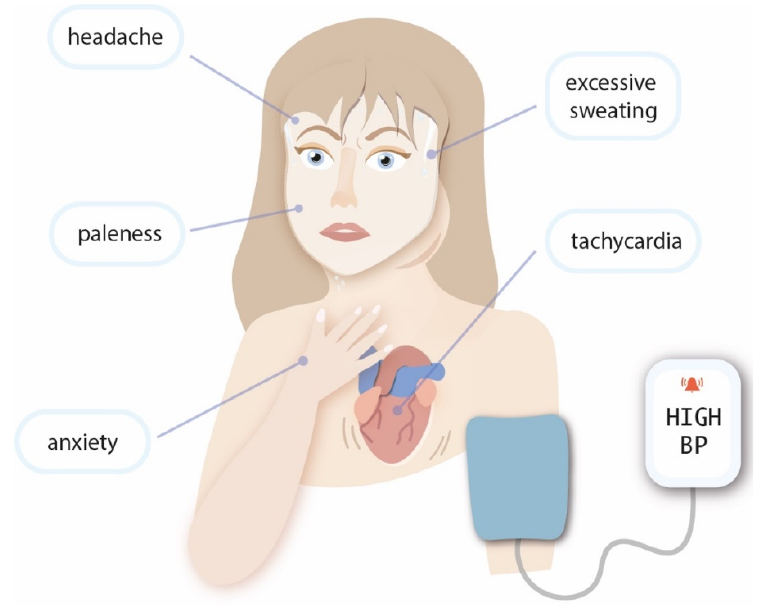
Figure 1. The clinical symptoms of pheochromocytoma and paraganglioma.